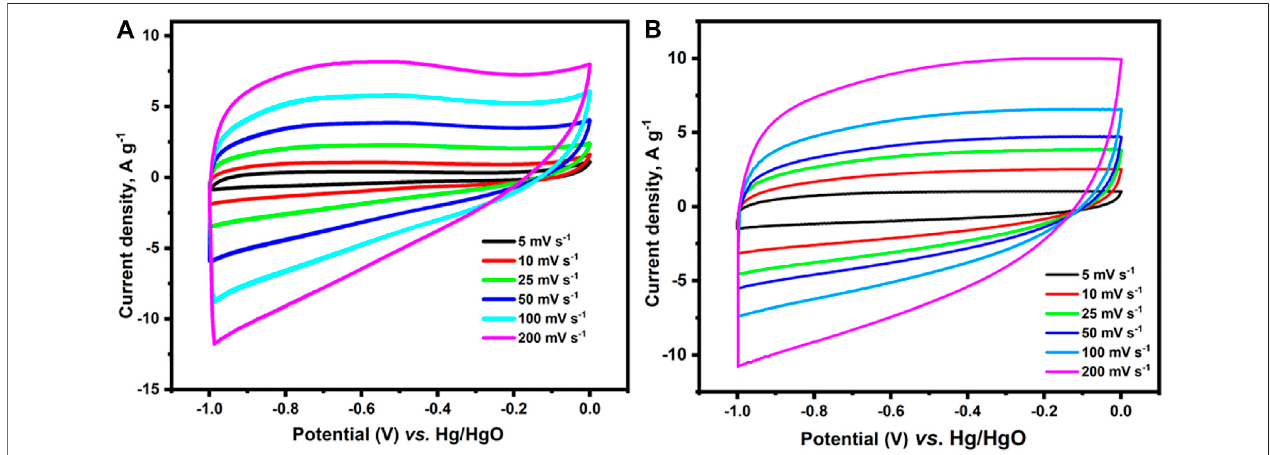
FIGURE 11 | Cyclic voltametric fi gures of (A) c-2CzPN – KOH and (B) c-4CzPN – KOH attained at various sweep rates.